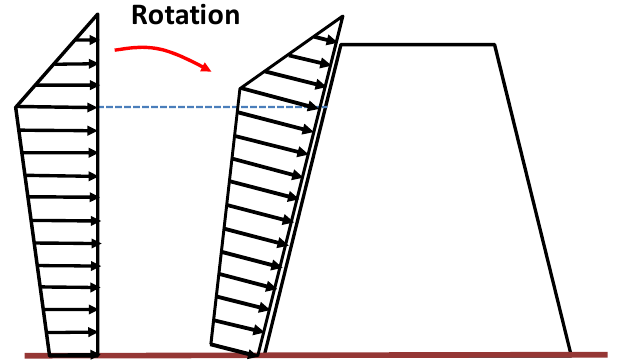
Figure 10. The method of Tanimoto and